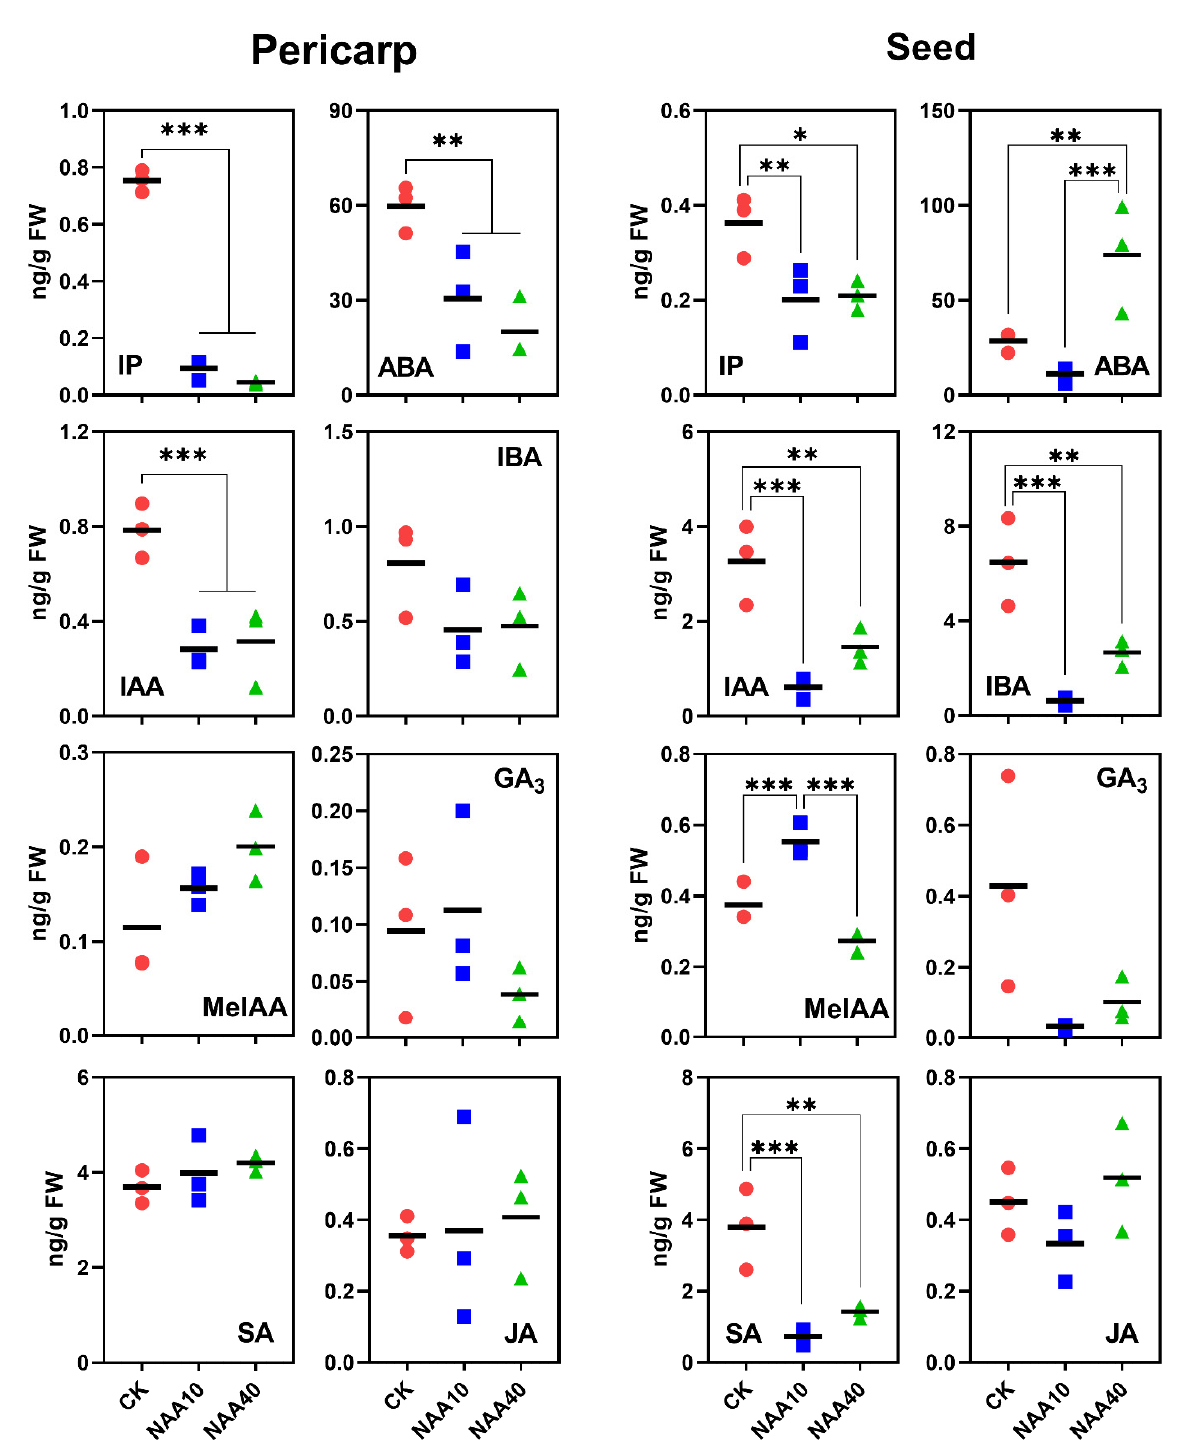
Figure 8. Scatterplots of phytohormone contents (ng/g FW) in pericarp and seed samples of control, 10 mg/L NAA (NAA10) treated grape berry and 40 mg/L NAA (NAA40) treated grape berry. The asterisk indicates a significant difference between treatments (Holm–Sidak t test, *, **, *** indicate p < 0.05, 0.01, 0.001).